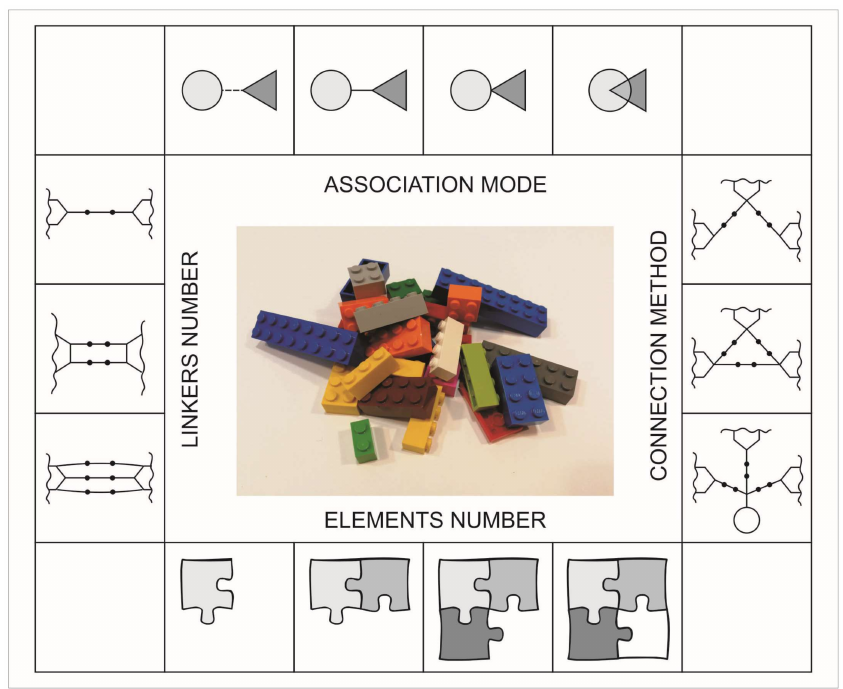
Figure 1. Molecular matrix for “Lego” chemistry